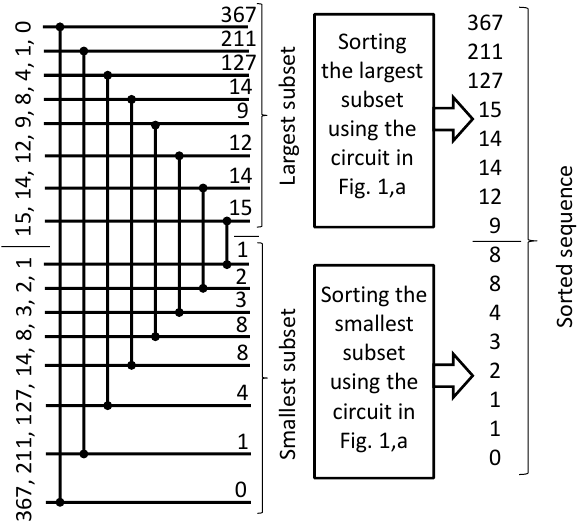
Fig. 3. An example of merging two sorted subsets in one sorted subset. Each subset has two associated counters pointing respectively to the current maximum and minimum items through the first and the second memory ports. The registers R max and R min keep K maximum items (one from each subset) and K minimum items (one from each subset), respectively. The registers and the memory are filled in during forming sorted subsets. Sorting is executed as